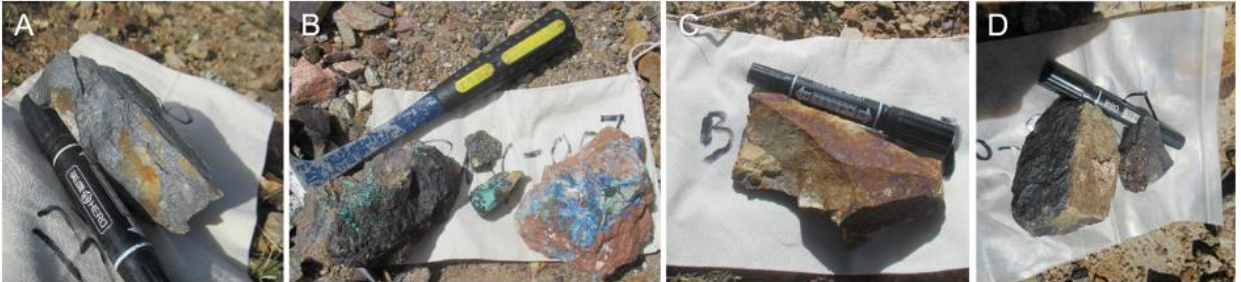
Figure 17. Field photographs of the study areas: ( A ) chalcopyrite-bearing diorite in Tiegelong; ( B ) malachite ( left and middle ) and azurite ( right ) in Duobuza; ( C ) Gossan in Gaerqin; and ( D ) chalcopyrite mineralization in Naton.